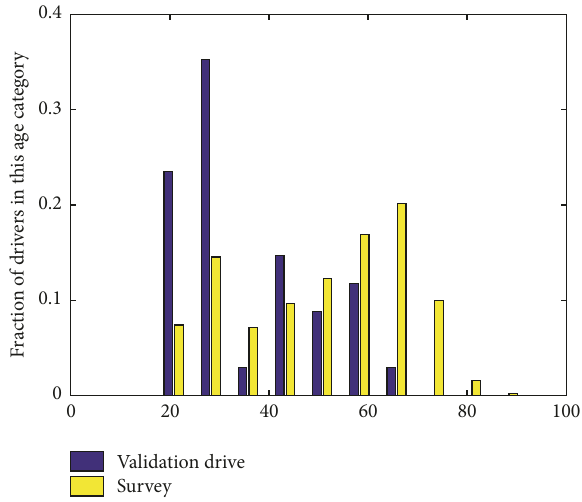
Figure 2: Age distribution of the respondents in the survey and participants in the